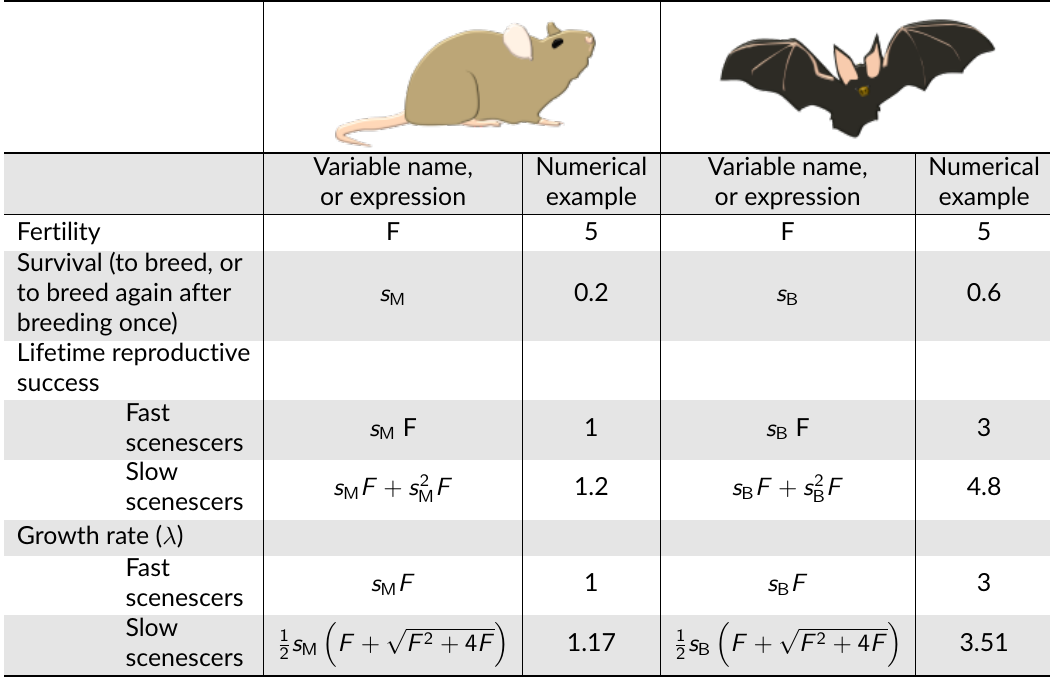
l ( a ) is the proportion of individuals surviving until age a , and b ( a ) is the mean reproductive output of these survivors. For exam- the slow mouse the